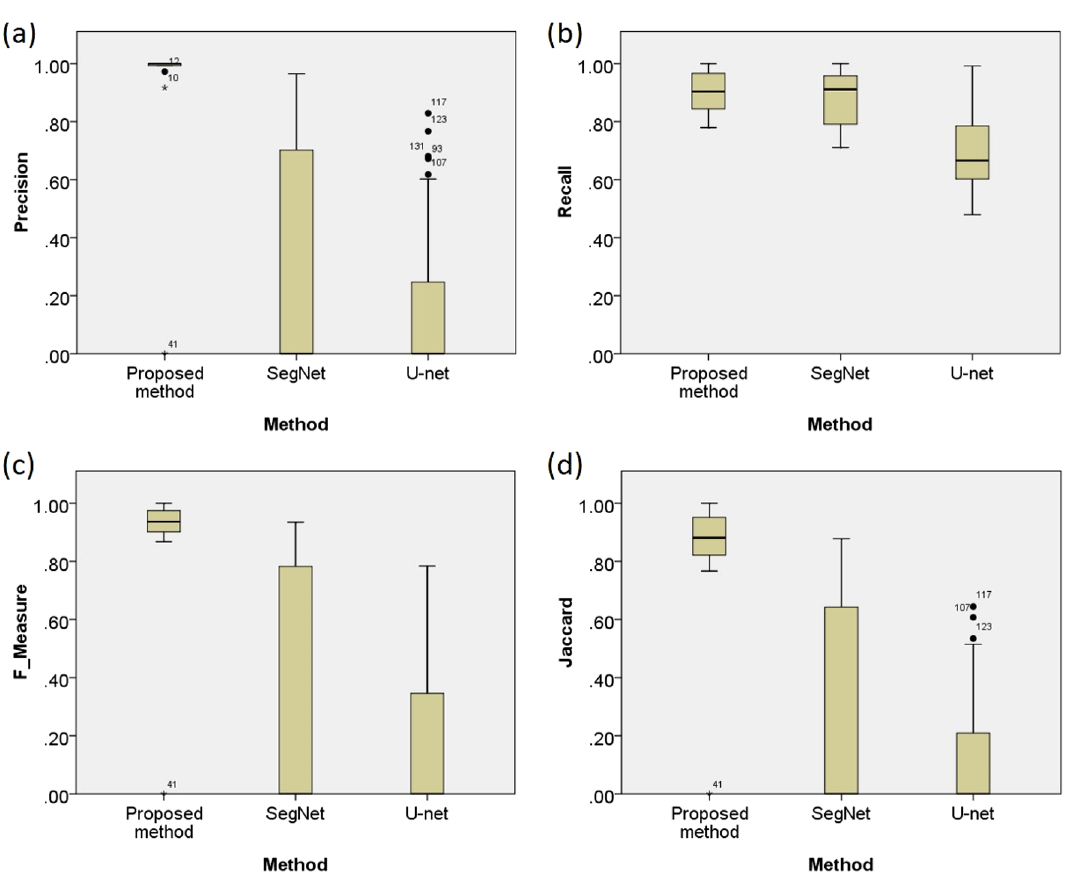
Figure 4. The box plot of quantitative evaluation results in HSILs or higher (SQCC) segmentation. The presented method works constantly well overall and outperforms the state-of-the-art benchmark methods. Outliers greater than 1.5 × and 3 × the interquartile range are marked with a dot and a asterisk,